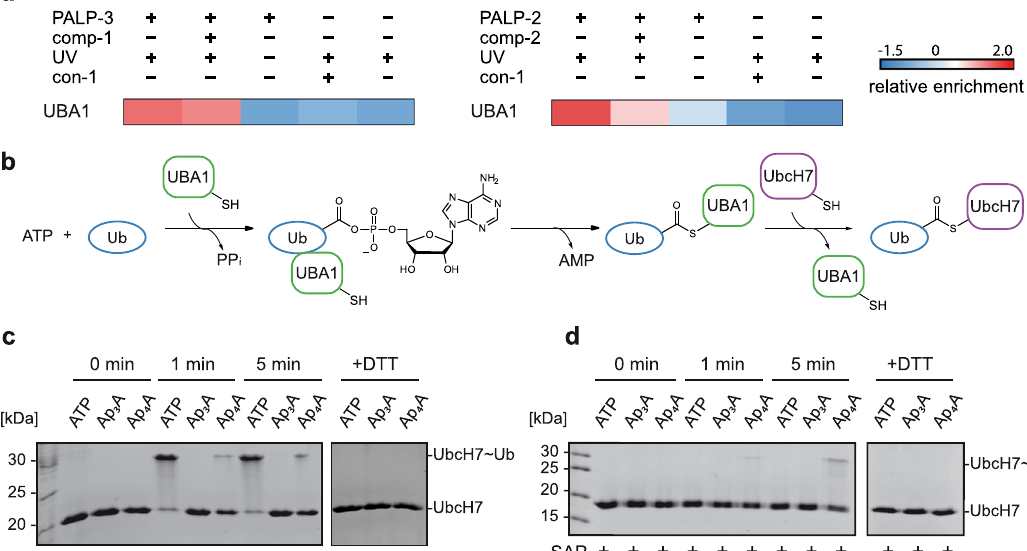
Fig. 5 Investigation of the interaction of Ap n As with UBA1. a Extract of ANOVA-heatmap ( Z -scores) for UBA1 under different PAL conditions. b ATP- dependent Ub activation and transthioesteri fi cation reactions catalyzed by UBA1. c Detection of Ub transfer from UBA1 to UbcH7 in the presence of Ap 3 A, Ap 4 A or ATP, analyzed by non-reducing SDS-PAGE (15%) followed by Coomassie blue staining. d The nucleotides were incubated with SAP before performing the transthioesteri fi cation reaction to remove possible contaminants of ATP in the Ap 3 A and Ap 4 A samples. The experiments were performed twice with matching results. Source data are provided as a Source Data fi le.